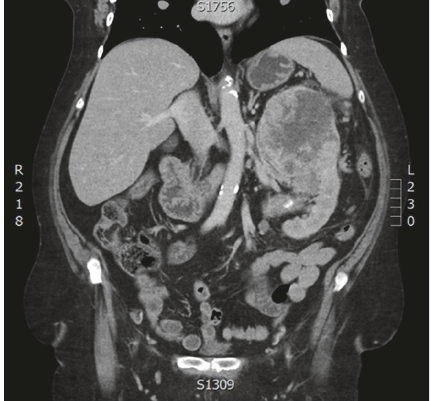
Figure 3: CT abdomen coronal view showing a large heterogeneous left renal mass with suspected splenic hilar